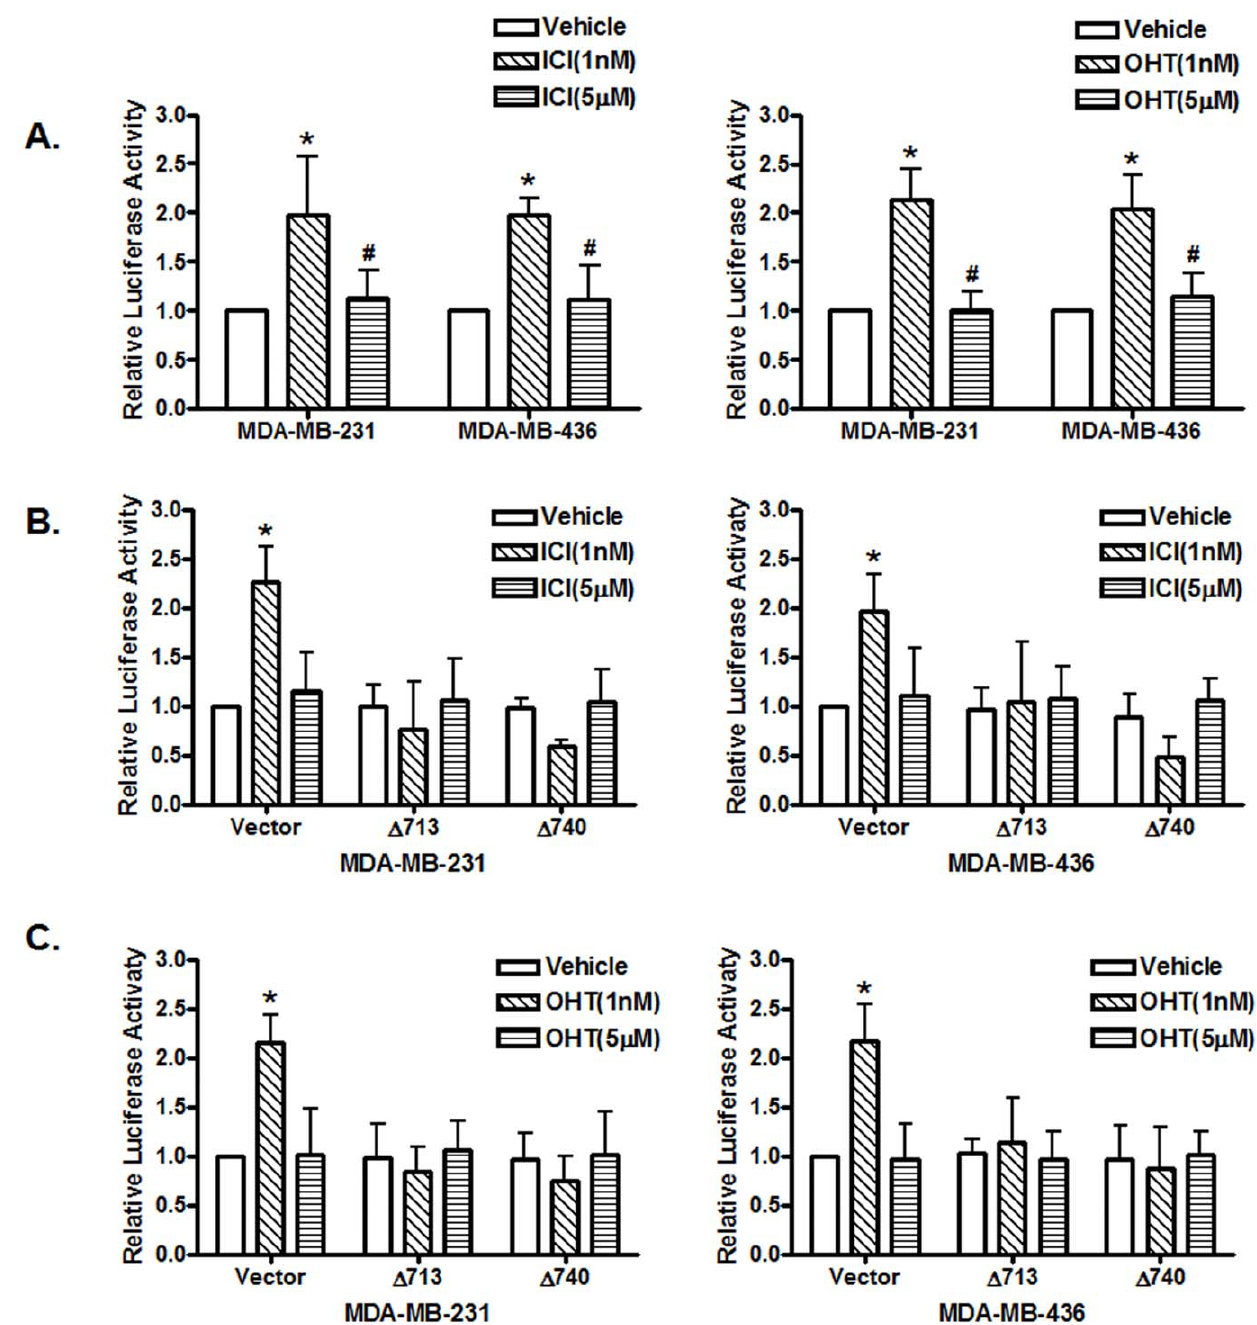
Figure 3. Antiestrogens induce biphasic STAT5 activities in ER-negative breast cancer cells. (A). ER-negative breast cancer cells were transfected with the luciferase reported plasmid 4XM67 TATA-TK-Luc that containing four copies of STAT-binding sites upstream of the minimal TK promoter. Transfected cells were treated with vehicle (ethanol), 1 nM or 5 m M of 4-OHT or ICI 182, 780. The luciferase activities were assayed and normalized using a cytomegalovirus-driven Renilla luciferase plasmid. Columns: means of the relative luciferase activity from four independent experiments. Luciferase activity in transfected cells treated with vehicle is arbitrarily set as 1.0; bars, SE. *, p , 0.05, for cells treated with vehicle (V) vs 1 nM of antiestrogens. # , p , 0.05, for cells treated with 5 m M vs 1 nM of antiestrogens. (B&C). Cells were transfected with the 4XM67 TATA-TK-Luc reporter together with an empty expression vector (vector) and the expression vectors of two dominant-negative STAT5a mutants carrying truncations at their C-terminal (STAT5a D 713 and STAT5a D 740) before treated with vehicle (ethanol), 1 nM or 5 m M of antiestrogens. Columns: means of the relative luciferase activity from three independent experiments. Luciferase activity of cells co-transfected with an empty expression vector and treated with vehicle is arbitrarily set as 1.0; bars, SE. *, p , 0.05, for cells treated with vehicle (V) vs 1 nM of antiestrogens.